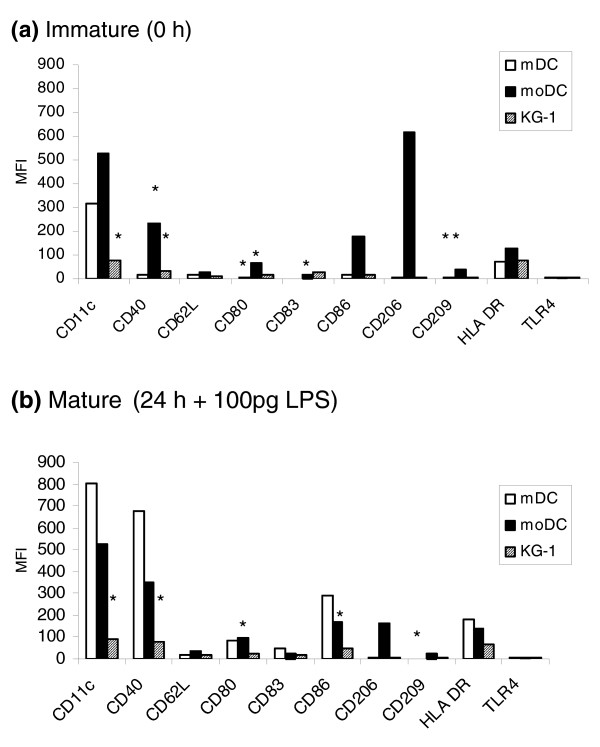
Phenotypic comparison of cells. The expression of cell surface markers on (a) immature and (b) mature mDCs, moDCs and KG1 cells. Immature cells were freshly isolated mDCs, moDCs, on day 6 of culture, and KG-1 cells stimulated with PMA and ionomycin for 24 h. Cells were matured in the presence of LPS (100 pg/ml) for 24 h. Shown are the mean fluorescence intensities of four individual experiments. Background levels of staining were determined using isotype controls. A Student t-test was carried out to determine the significance of the data (*p < 0.05).